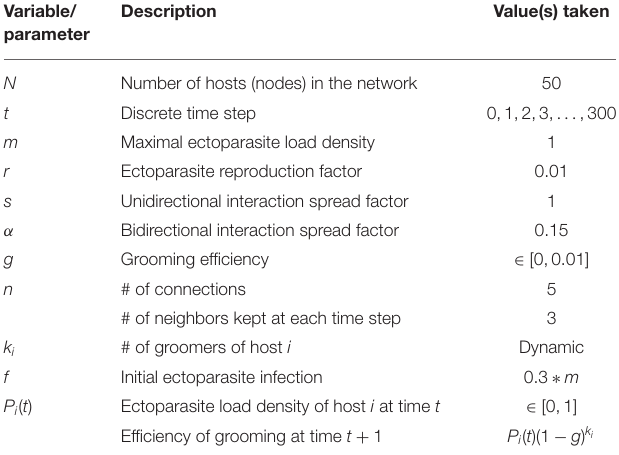
TABLE 1 | Parameter